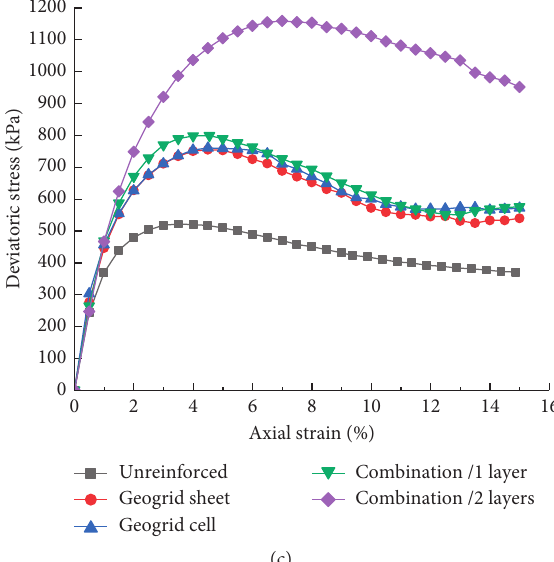
� 50 kPa, (b) σ � 75 kPa, and 3 3